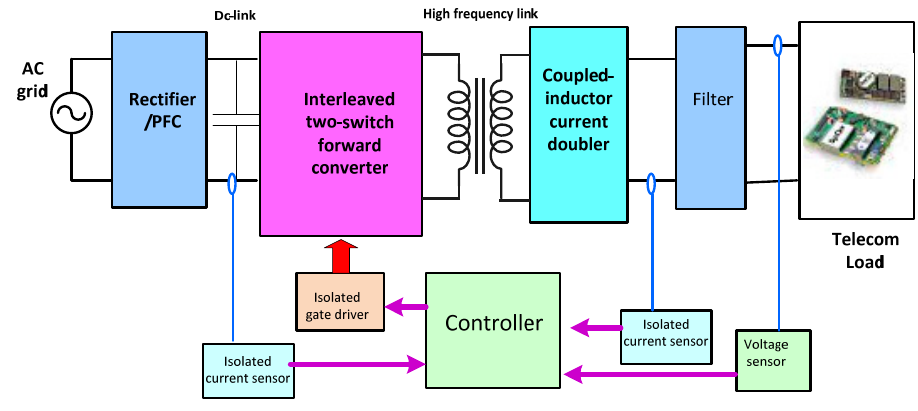
Figure 1. Basic building blocks of the proposed converter.